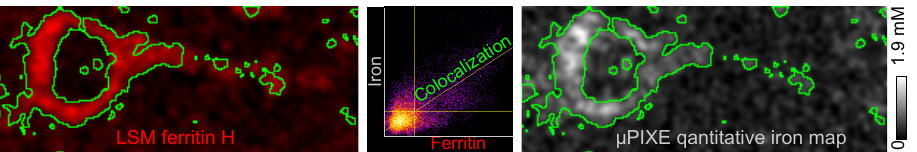
Figure 3. Correlative fluorescence and element microscopy. Co-localization of ferritin H and iron in the cytoplasm of an interneuron from the parietal cortex. Left panel: Cy3 signal from immunohisto- chemically stained ferritin H. Right panel: µPIXE quantitative element map of iron. Middle panel: Pixel scatter plot of signal correlation between ferritin H and iron. The pixels in the quadrant with the linear correlation define the area of co-localization (regions encircled in